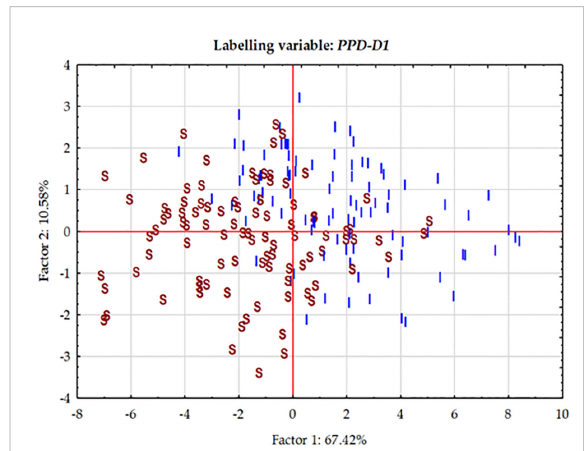
FIGURE 5 Principal Component analysis carried out on the phenotypic data matrix of the effective thermal times of fi ve consecutive developmental phases across three seasons in the group of 188 winter wheat genotypes. The cases are labelled by the allele phase in the PPD-D1 gene (I stands for insensitive, S for sensitive).